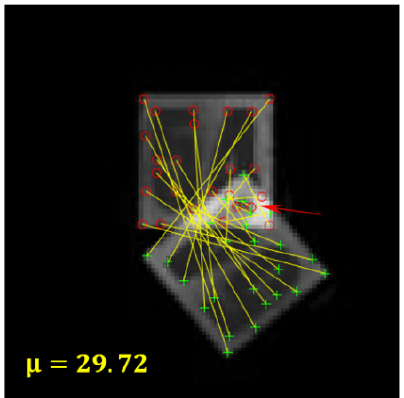
Figure 4. Correspondent points on the two images x 1 , x 2 and the found measure µ ( x 1 , x 2 ) .